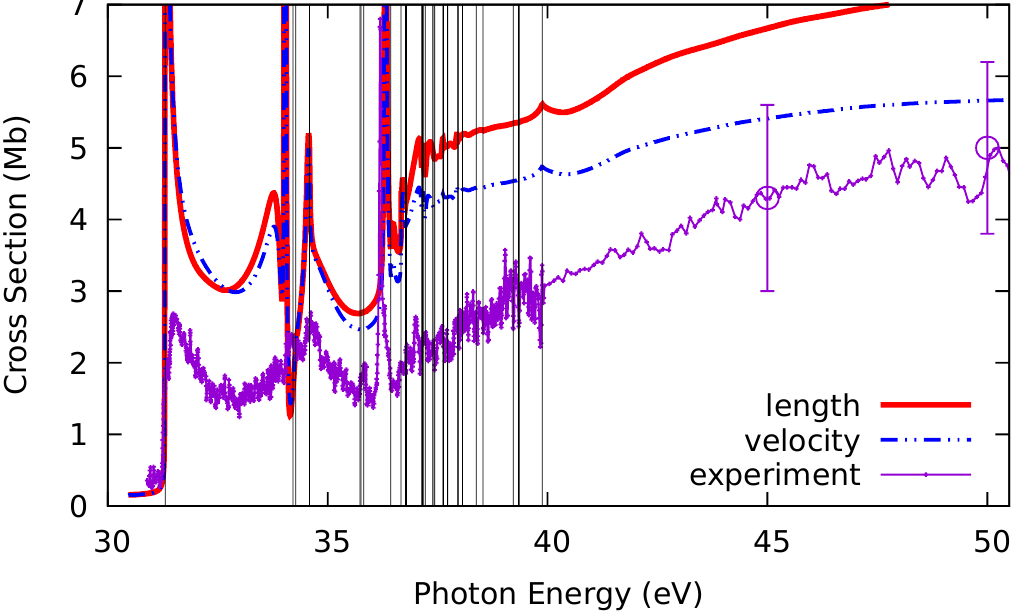
Figure 1. Calculated R-matrix Na − photodetachment cross sections compared to experiment [28]. The calculated inner-shell thresholds are shown as vertical black